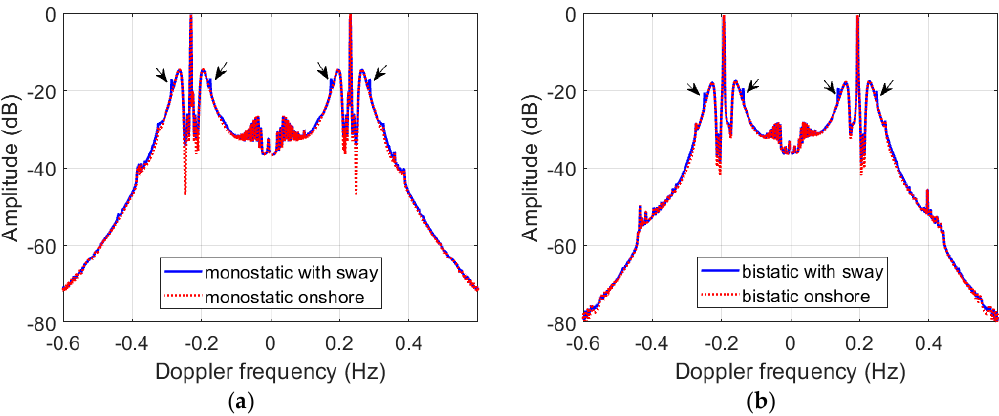
Figure 6. Simulated total RCSs containing first- and second-order RCSs, ( a ) for onshore and floating- based monostatic cases; ( b ) for onshore and floating-based bistatic cases. The black arrows represent additional sway-induced peaks.